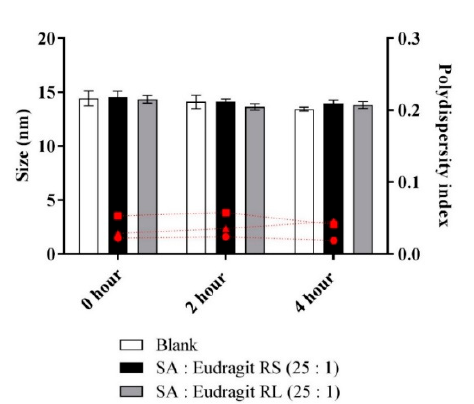
Figure 1. Sizes of micellar droplets used as blank (white bars) or containing SA-polymer complexes with Eudragit RS (black bars) and Eudragit RL (gray bars) and the polydispersity index (red symbols) at 0, 2, and 4 h time points after 1:100 dilution in 0.1 M phosphate buffer (pH 6.8) at 37 ◦ C. Indicated values are the means ± SD ( n ≥